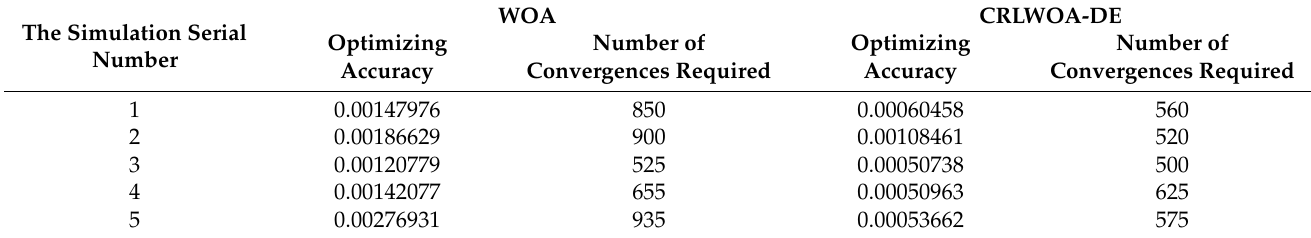
Table 2. Comparison of optimization results between whale optimization algorithm and improved whale optimization